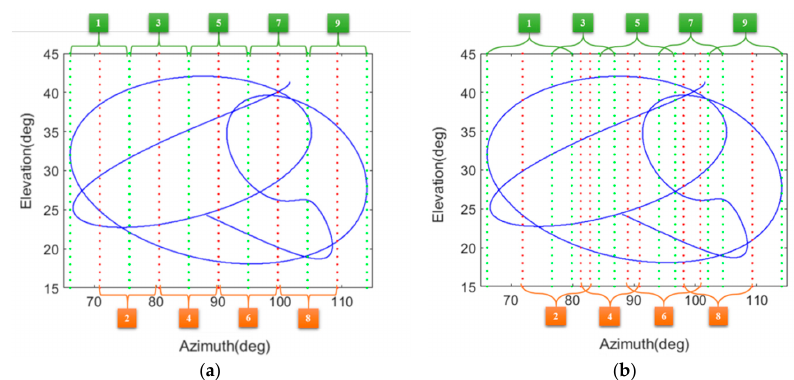
Figure 7. Result of sub-aperture partitioning. ( a ) Equal-interval; ( b ) non-uniform.